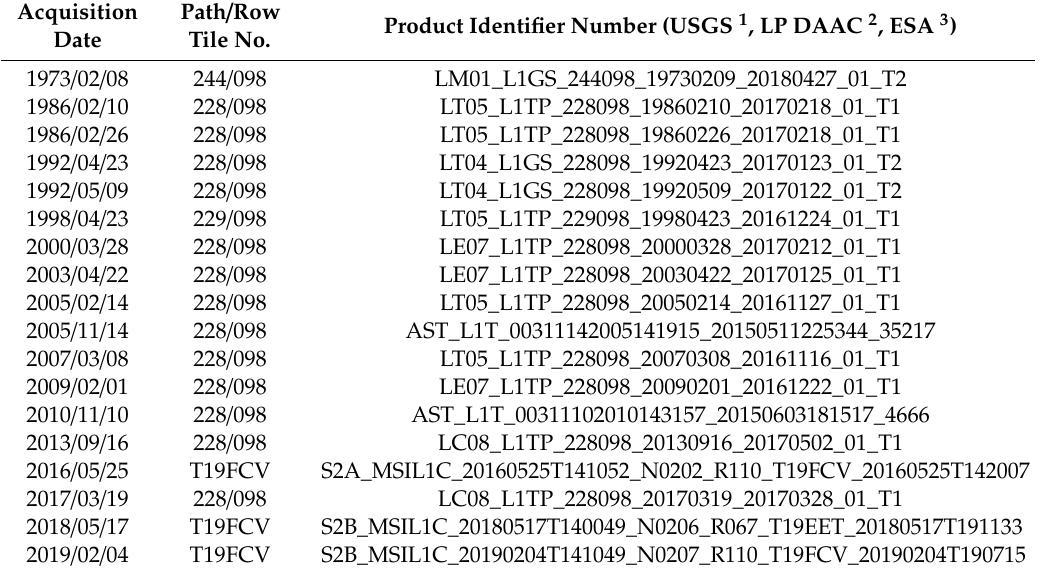
Table A1. Satellite Scenes Used for the Glacier Mapping (LM, LE, LT, LC = Landsat Mission; AST = ASTER Collection; S2 = Sentinel-2).